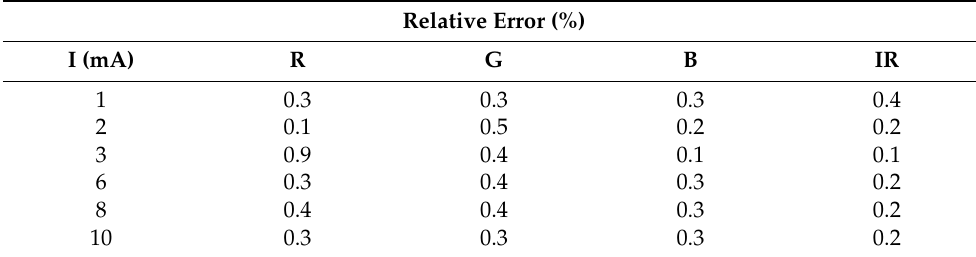
Table 1. Error for different bias currents.